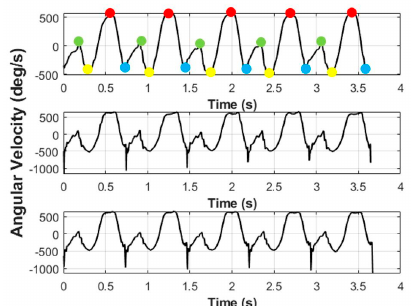
Figure 2. Gyroscope running gait profile for soft sand ( top ), hard sand ( middle ) and running track ( bottom ) (participant 1); green circle = full contact (FC), yellow circle = terminal contact (TC), red circle = mid-swing (MS) and blue circle = initial contact